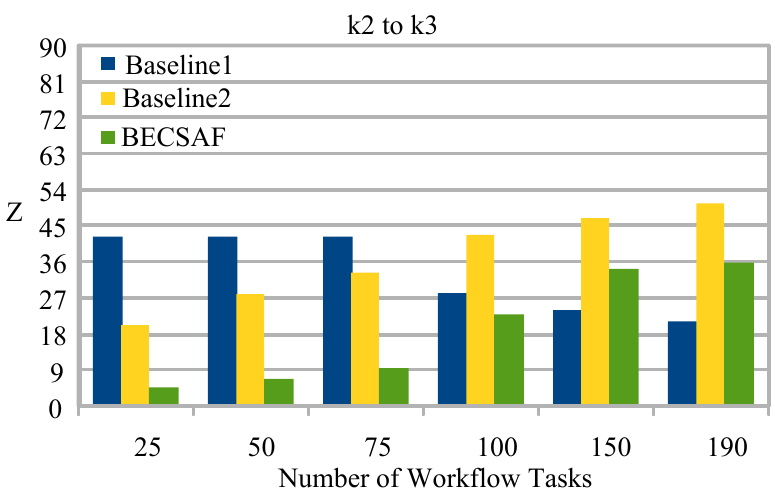
Figure 8. Cost of Failure Between Fog Node k 2 to k 3 During Data Travelling.